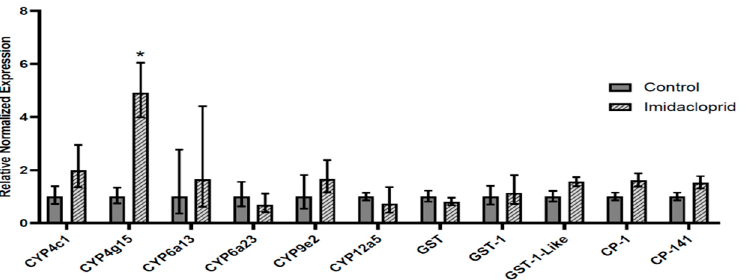
Figure 3. Expression of transcript levels, normalized to RP-18 , in imidacloprid-treated versus untreated insects. Data are mean standardized transcript levels (mean ± SEM, n = 3). Asterisks depict results that are significantly different (* p < 0.05).